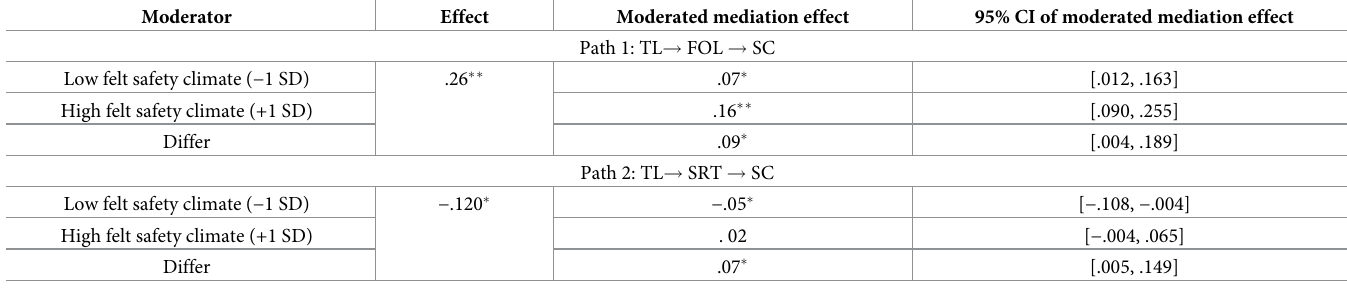
Table 6. Conditional indirect effects of transformational leadership on safety compliance at values of perceived safety